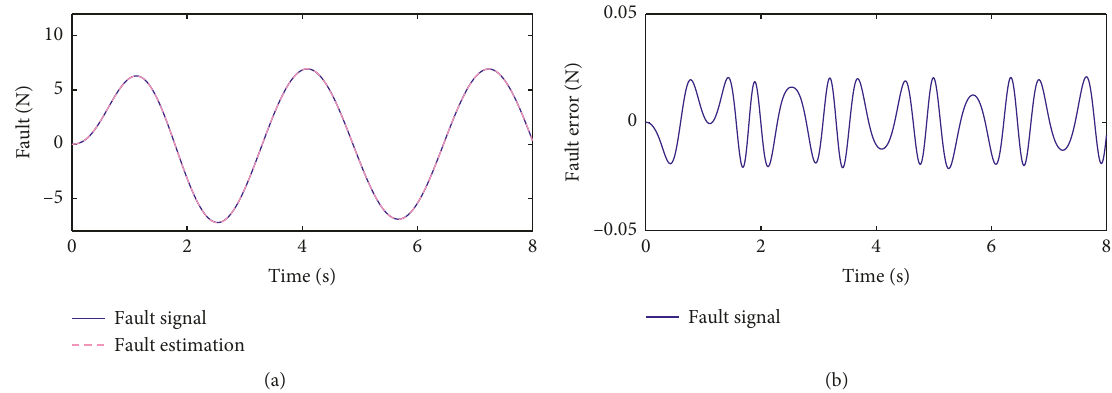
Figure 6: The variations of (a) fault estimation and (b) fault estimation error for the sinusoidal fault